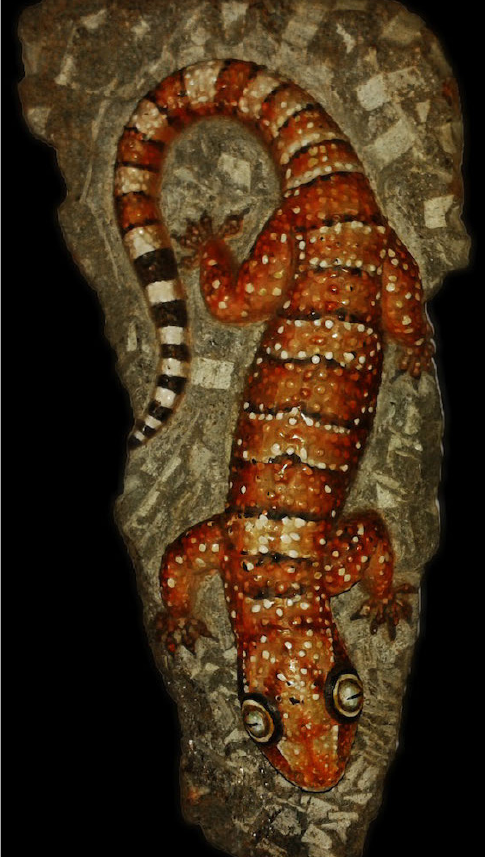
Image 3. A three-dimensional carving of a Chameleon Chamaeleon zeylanicus exhibiting bright colouration. This sort of carving necessitates the removal of large quantities of stone. Pichandikulam, Auroville.